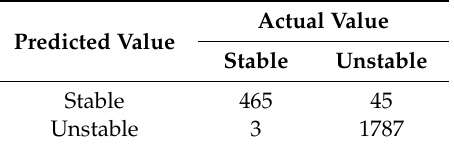
Table 3. Stability prediction results (first 100 cycles).